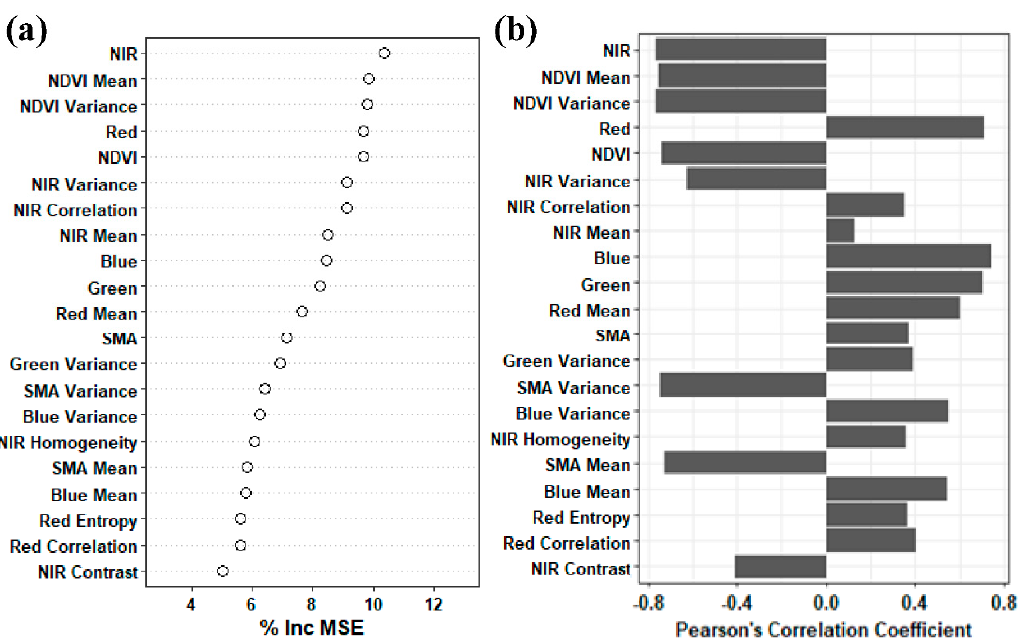
Figure 3. Predictor importance ranking derived from the best random forest model. ( a ) The rank is based on the increase of mean square error (% Inc. MSE) when the explanatory variable is removed. ( b ) Pearson’s correlation coefficients between explanatory variables and tree species deciduousness measured in the field. All correlations were significant ( p < 0.001).